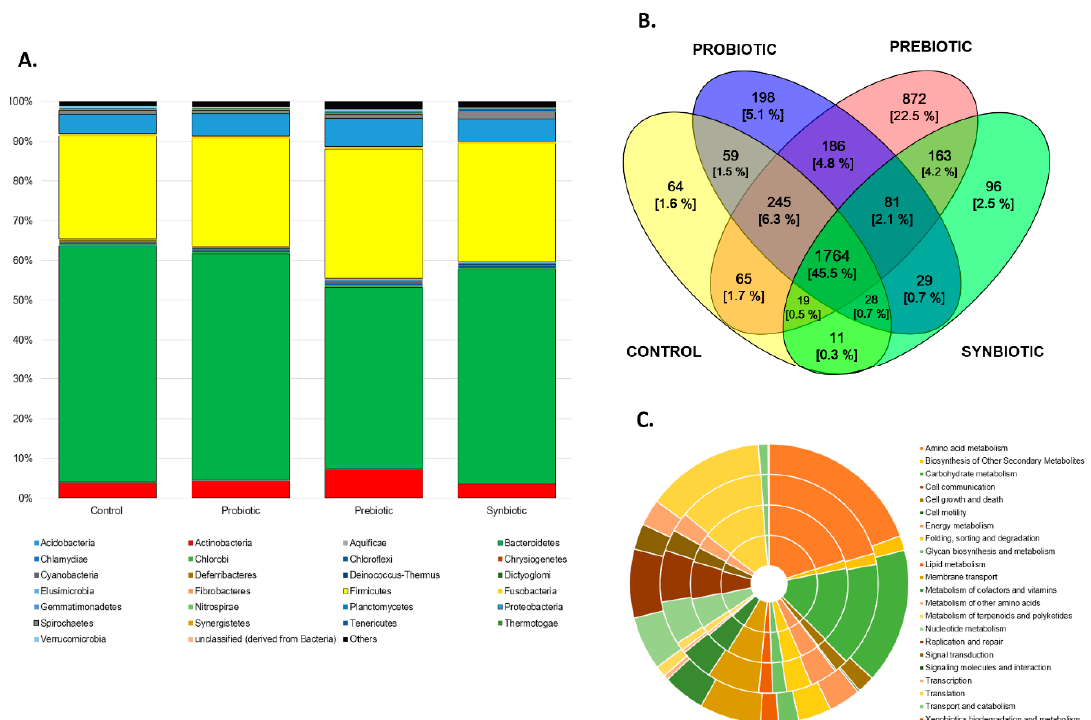
Figure 3. ( A ) Taxonomical assignation based on the KEGG protein database. The groups are shown at the phylum level. ( B ) Venn diagram depicting the percentage of genes assigned and shared between the four metagenomes (the color convention indicates, yellow for control, blue for the probiotic, red for the prebiotic, and green for the synbiotic. ( C ) KEGG orthologs obtained from the four metagenomes. The classification corresponds to the second level, and it was plotted as follows—the inner circle corresponds to the control, the second to the probiotic, the third to the prebiotic, and the outer circle corresponds to the synbiotic diet.